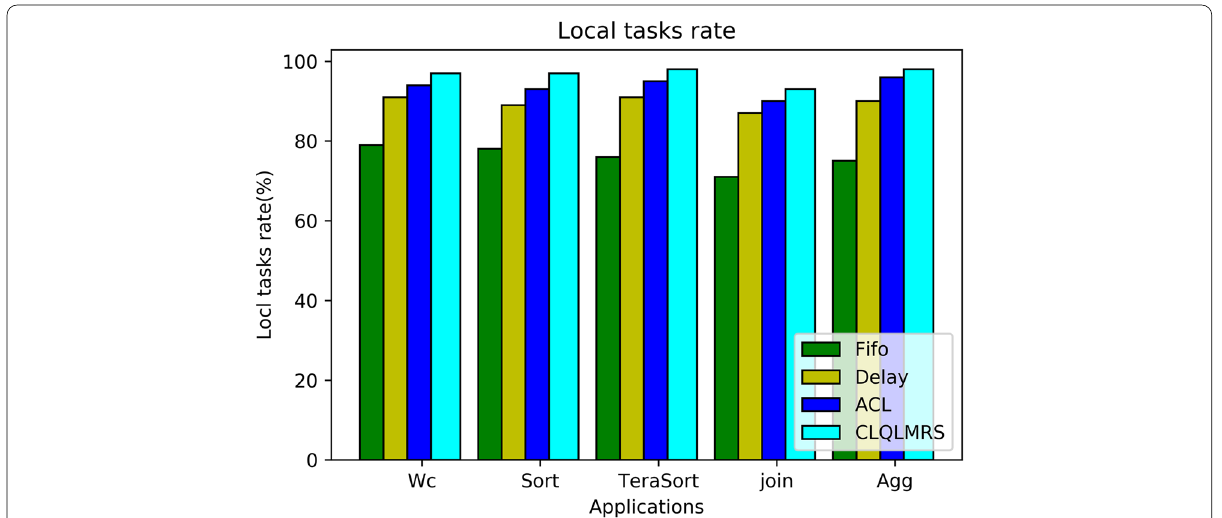
Fig. 8 Local tasks rate for different